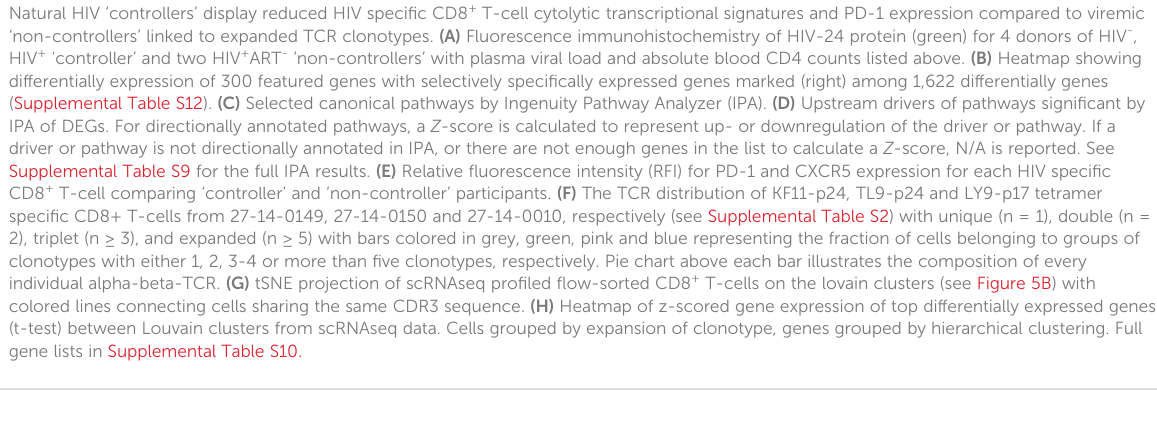
(t-test) between Louvain clusters from scRNAseq data. Cells grouped by expansion of clonotype, genes grouped by hierarchical clustering. Full gene lists in Supplemental Table